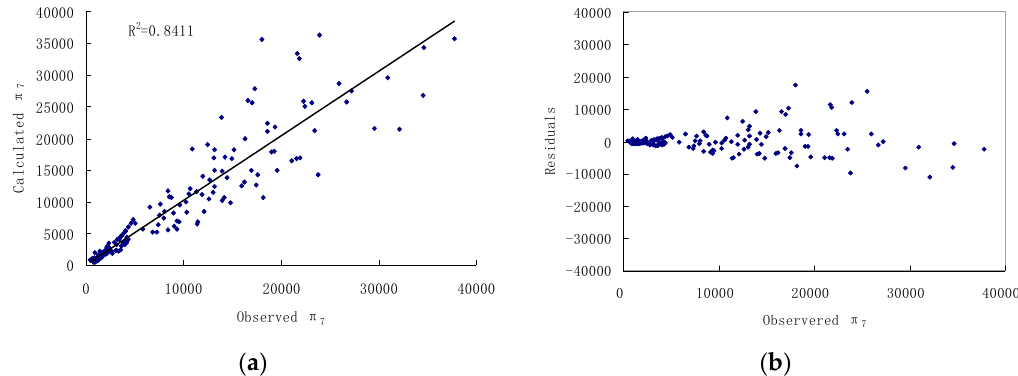
π , the calculated value from Equation (6) ( a ), and residues ( b ). p Figure 1. The measured value of Figure 1. The measured value of π 7 , the calculated value from Equation (6) ( a ), and residues ( b ). 7 < 0.05. p < 0.05.